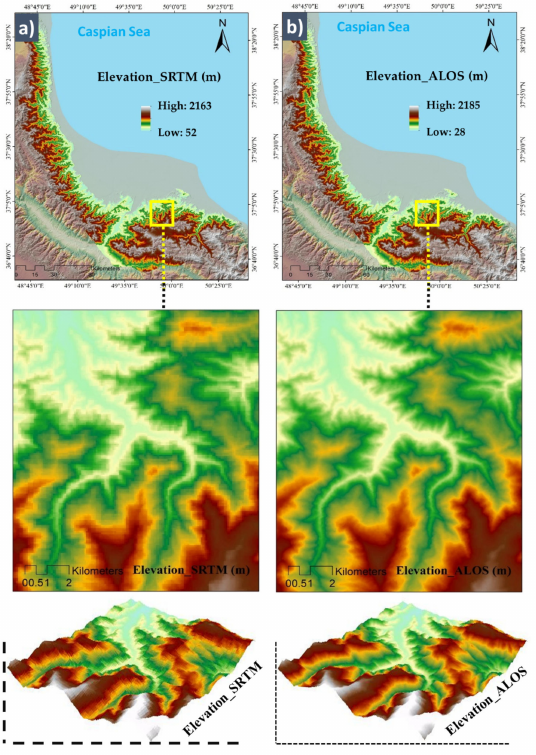
Figure 4. Representation of the applied digital elevation models (DEMs) of ( a ) SRTM and ( b ) ALOS.